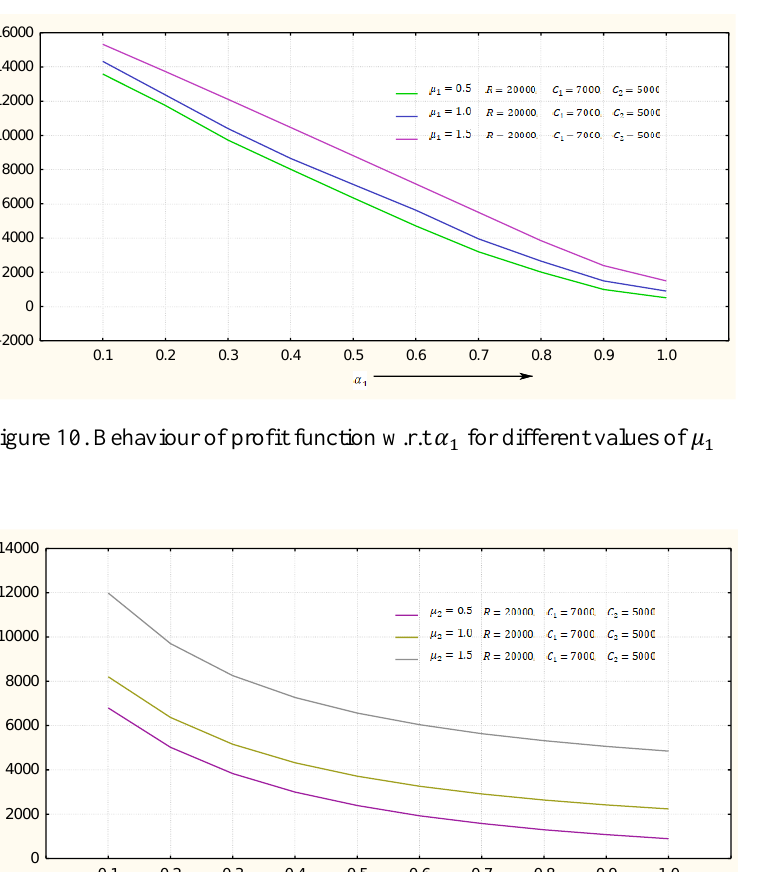
for different values of 𝜇 2